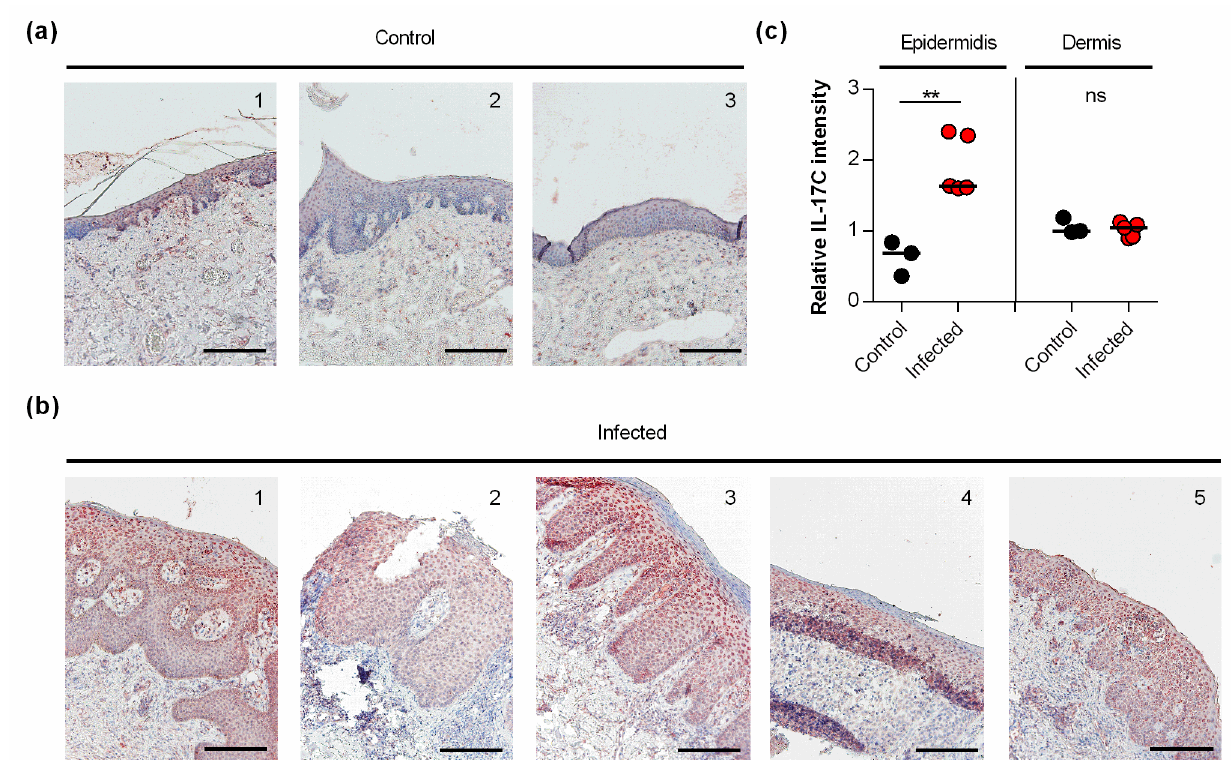
Figure 4. IL-17C is expressed in S. aureus -infected skin ( a , b ). IL-17C was detected by immunohistochemistry in formalin- fixed, paraffin-embedded skin samples obtained from 3 non-infected individuals ( a ) and 5 patients with S. aureus skin infection ( b ). Scale bar, 100 µ m. ( c ) The relative IL-17C intensity was quantified in the epidermis and dermis in relation to the staining intensities seen with hematoxylin in the respective regions. Relative IL-17C intensities between non-infected (black symbols) and S. aureus infected (red symbols) wound biopsies were compared by unpaired Student’s t -test. **, p <